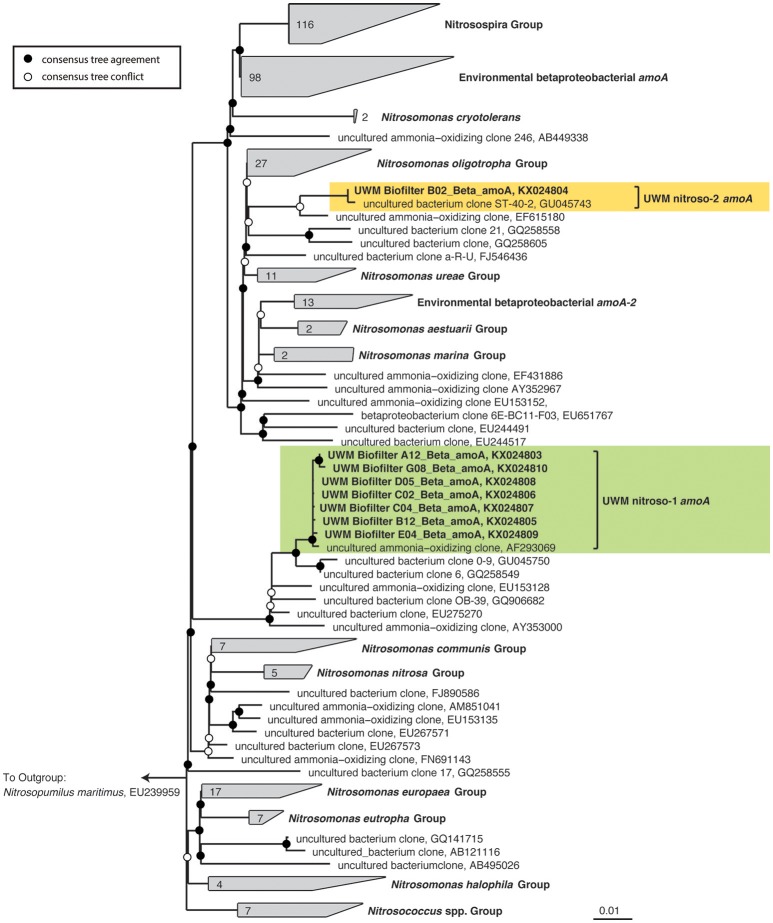
Ammonia-oxidizing Bacteria consensus tree. A consensus phylogenetic tree was generated from maximum likelihood and Bayesian inference phylogenetic reconstructions. Consensus tree support is indicated by colored circles at tree nodes. Collapsed nodes and assigned names are based off of Abell et al. (2012). Clone and taxonomic names are followed by NCBI accession numbers. The clade containing Nitrosomonas amoA genotype, UWM nitroso-1 amoA is highlighted in green, and UWM nitroso-2 amoA is highlighted in yellow.